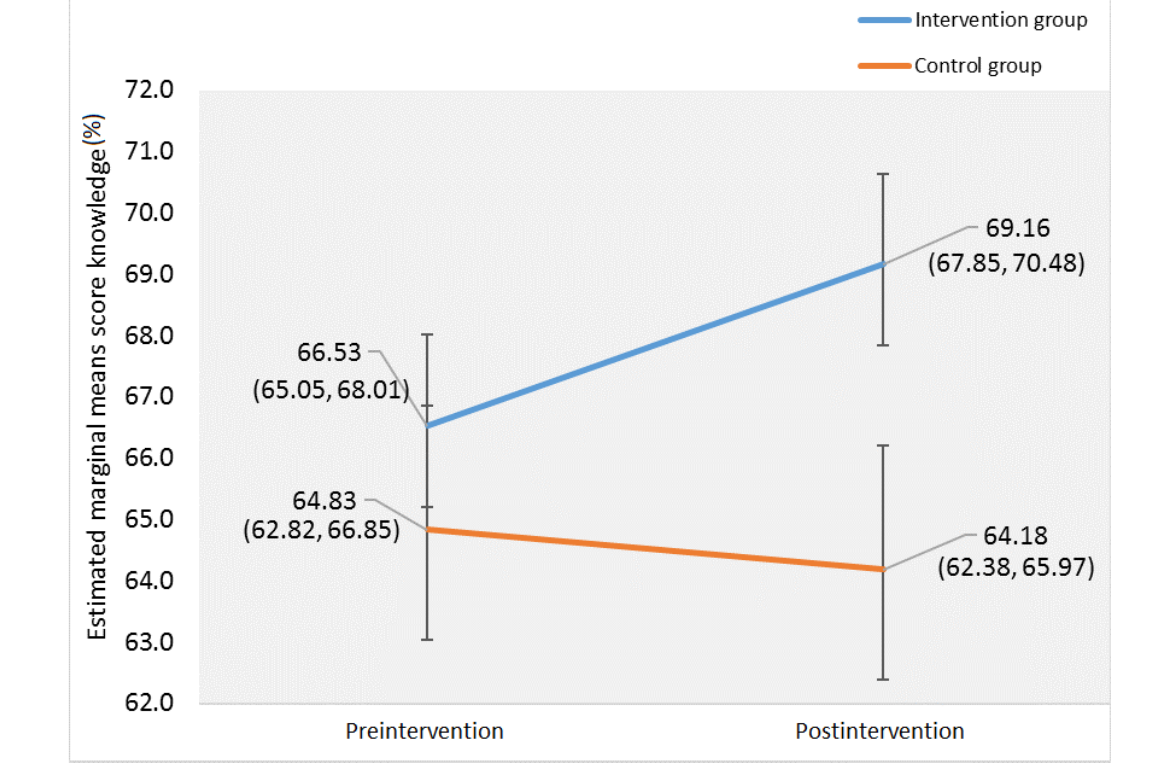
Control groupIntervention groupTime